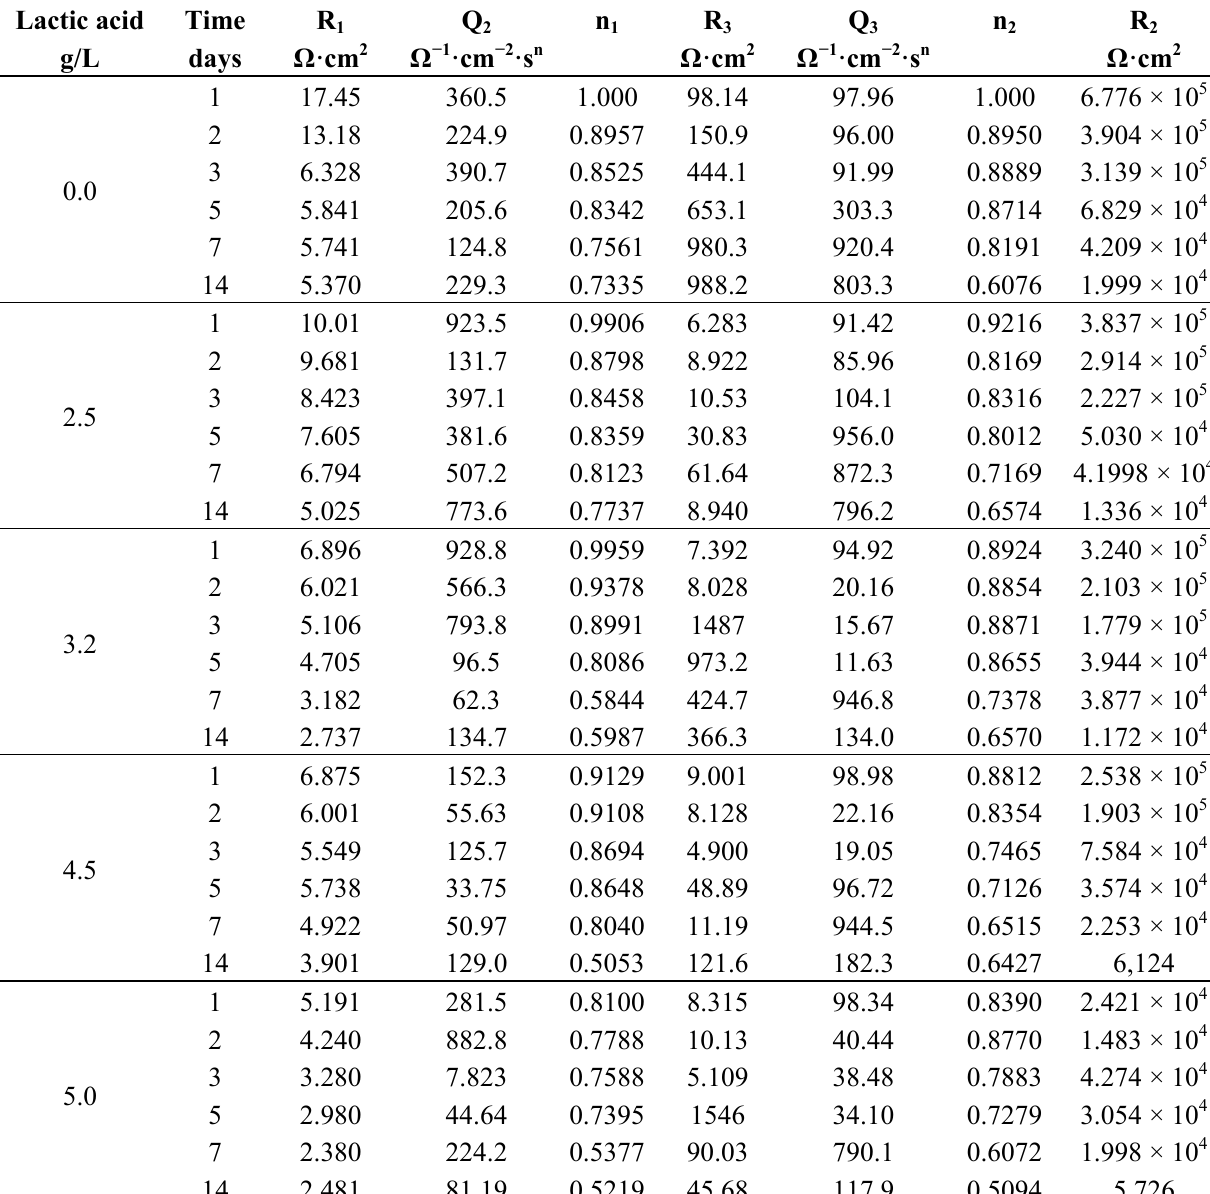
Table 1. EIS parameters of titanium immersed for different times in artificial saliva containing different amounts of lactic